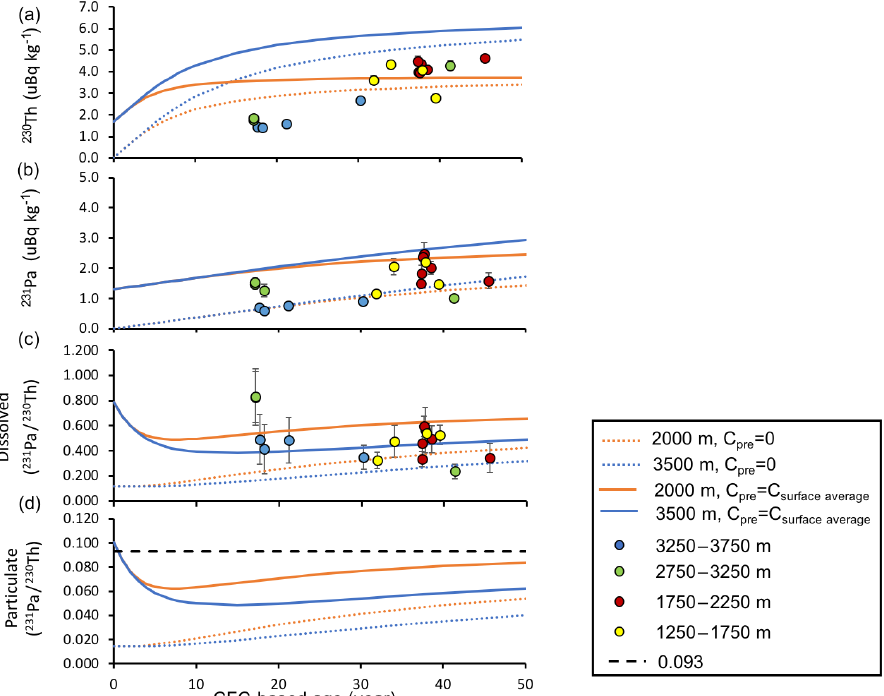
Figure 9. Results from a scavenging-mixing model of 230 Th, 231 Pa, dissolved 231 Pa / 230 Th, and particulate 231 Pa / 230 Th compared to observations. Preformed concentration ( C pre ) were set at 0 (dashed line) and at the average surface concentration ( C surfaceaverage ) from GEOVIDE section (solid line), i.e. 230 Th = 1.66µBqkg − 1 and 231 Pa = 1.31µBqkg − 1 . A version of this figure extending to older waters is available in Fig. S2.